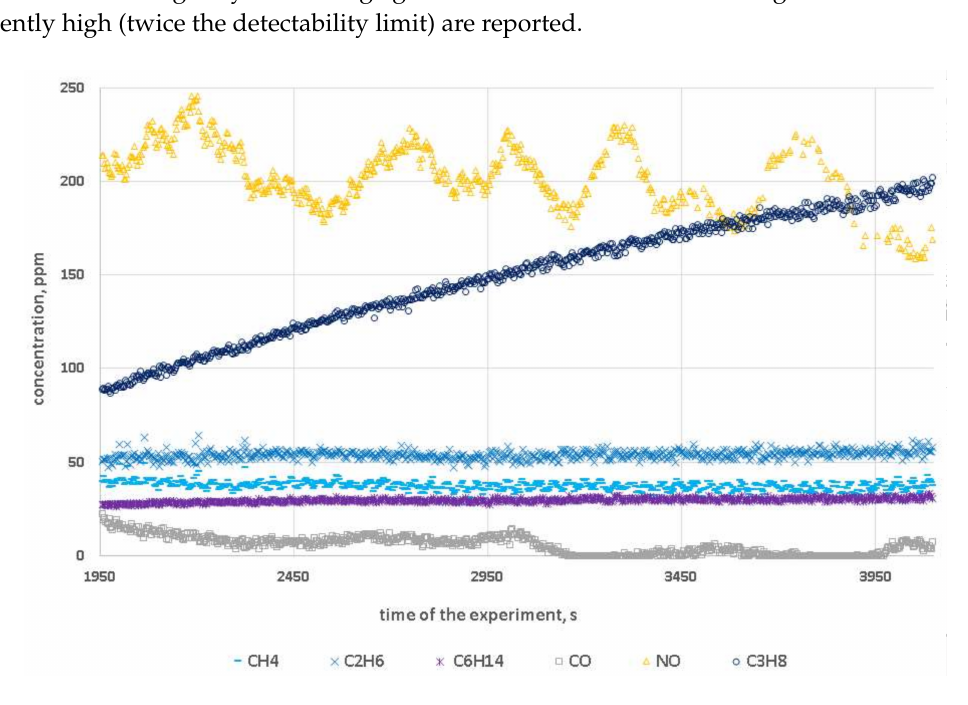
Figure 3. Composition of the torgas—minor